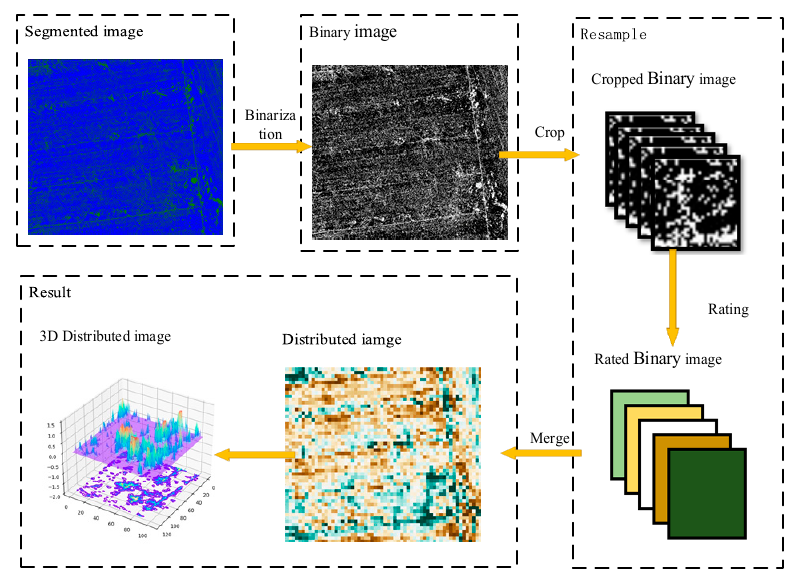
Figure 4. Flowchart of resampling the normalization algorithm shows that the green and blue pixels in the segmented image are the kiwifruit vine and ground, respectively. After binarization, the image is clipped with multiple sampling sizes, and the proportion of the kiwifruit pixels in each image is calculated. Then, the color is filled according to the gradient order. Finally, the vine distribution map is generated.